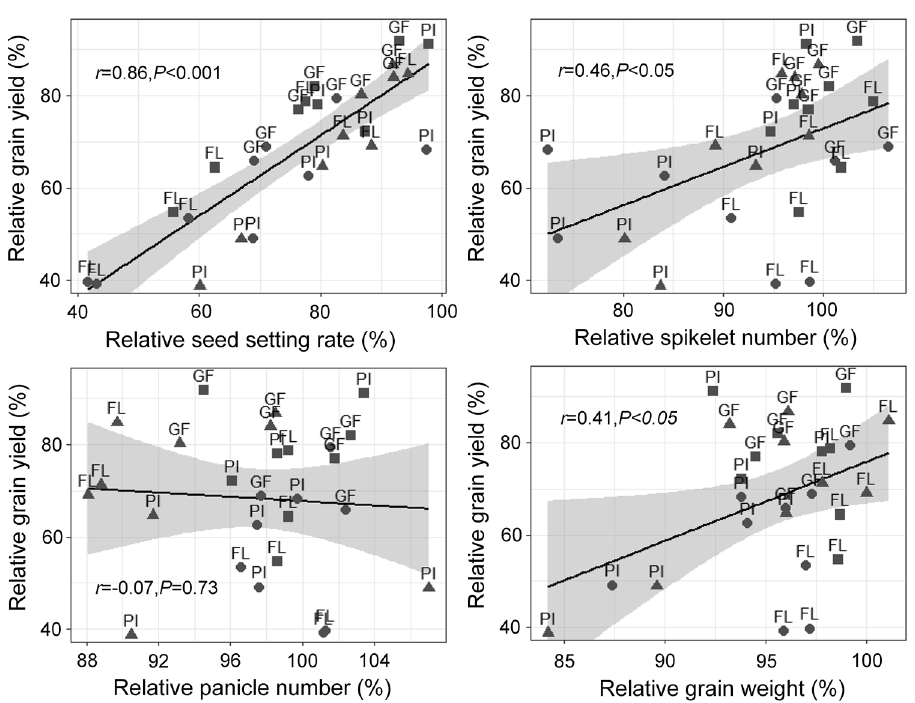
Figure 2. Relationship between relative grain yield and relative yield components. PI, panicle initiation stage; FL, flowering stage; GF, grain filling stage; filled circle, Liangyoupeijiu; filled triangle, Nagina22; filled